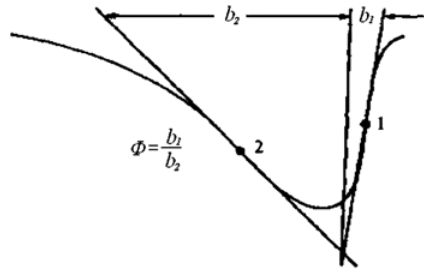
Figure 6 Φ of the DTA